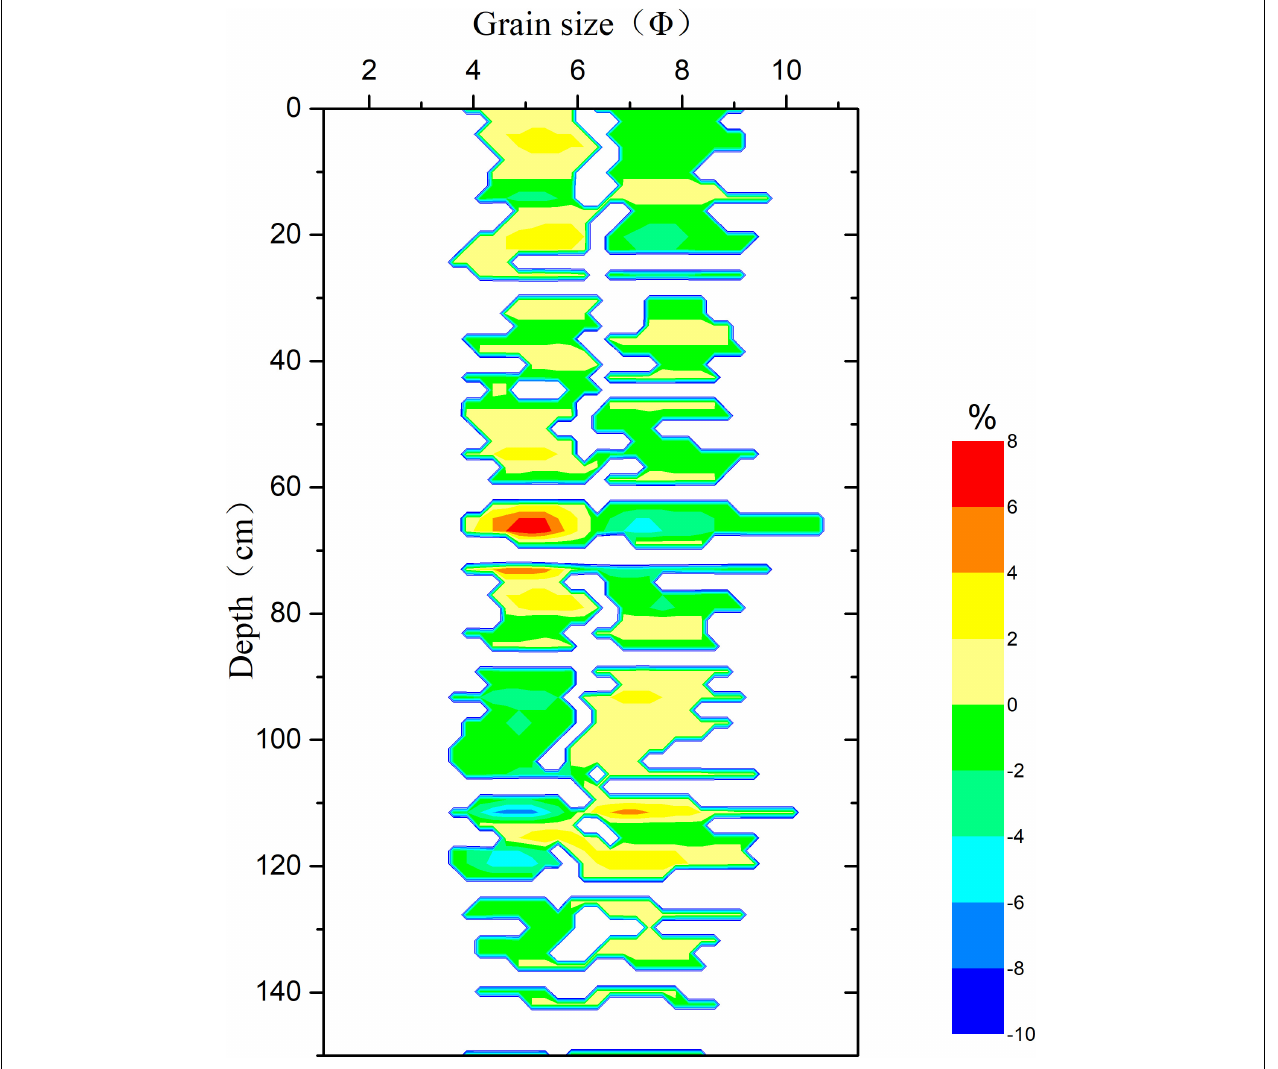
FIGURE 7 | Difference in grain size components between two cores at 1-cm-intervals. It was obtained by subtracting the content of the grain size components of Z8 from that of Z7. % is represented the content of special grain size components. So a positive value (+) meant the content of the grain size components of Z7 was more than that of Z8 in that layer, and a negative value (–) meant the content of the grain size components of Z7 was less than that of Z8. The results showed that there was a tendency for grains in Z7 to coarsen relative to those in Z8 from 1977 (the depth of 70